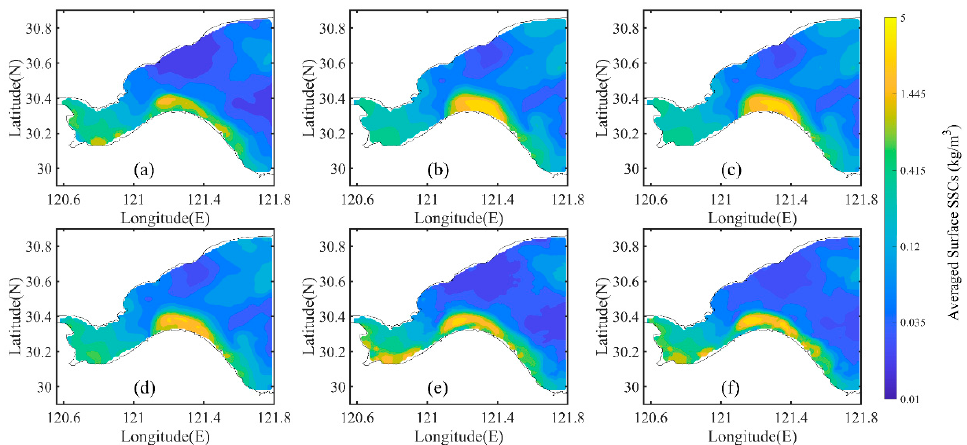
Figure 7. Spatial distribution of temporally averaged SSCs at sea surface: ( a ) the interpolation results of GOCI-retrieved SSCs, ( b ) the simulated results without adjoint data assimilation, and the simulated results in ( c ) PE11, ( d ) PE12, ( e ) PE21 and ( f ) PE22.